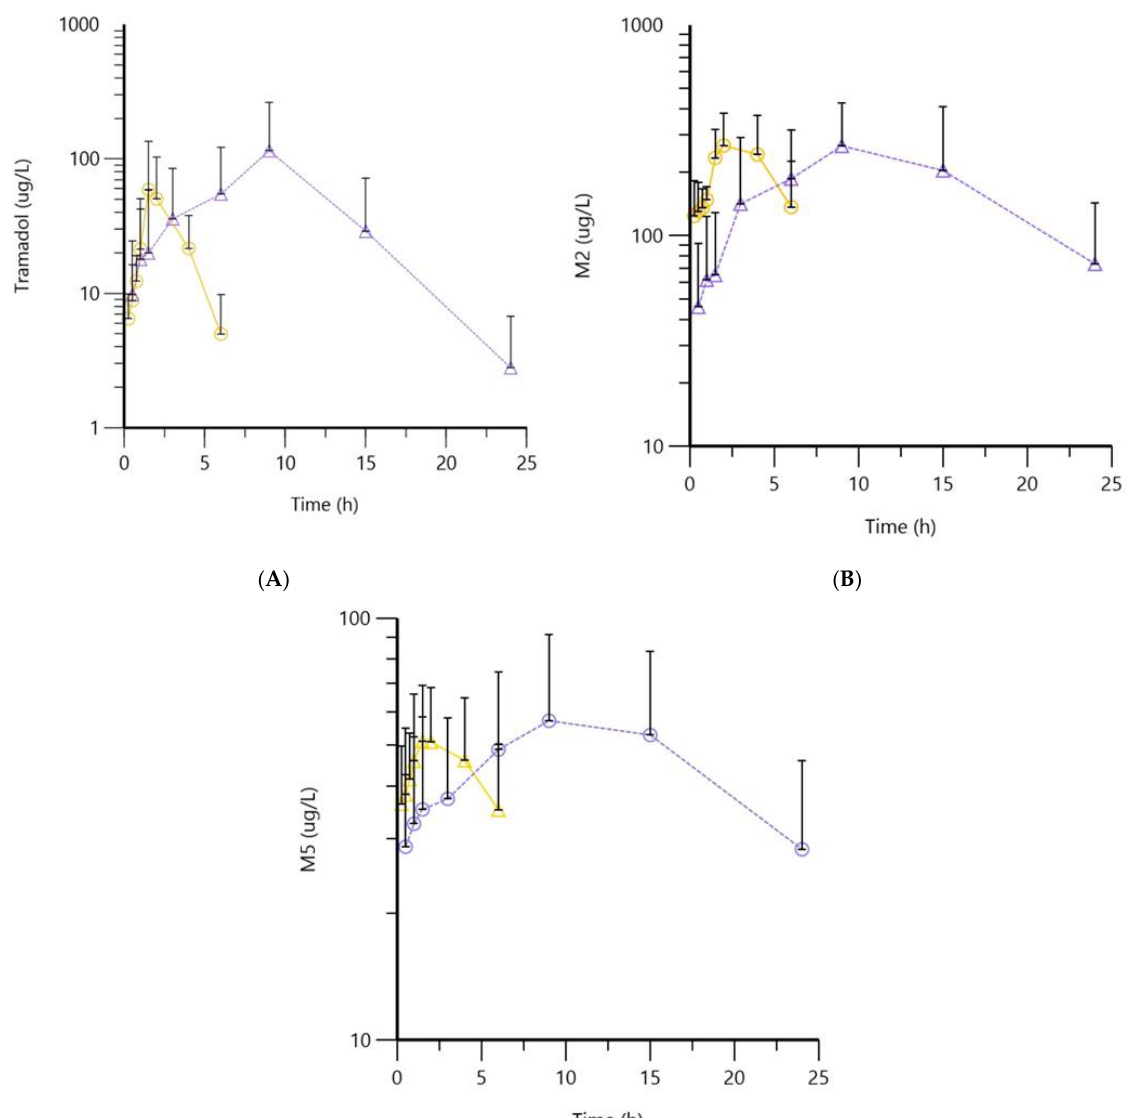
Figure 1. Mean (triangles show the mean concentrations after administration of the IR formulation and circles the mean concentration after administration of the SR formulation) and standard deviation of tramadol ( A ), M2 ( B ) and M5 ( C ) serum concentrations over time, after administration of IR (yellow lines) and SR (purple lines) formulations. In these graphs, all measured values are included, as well as values below LLOQ.